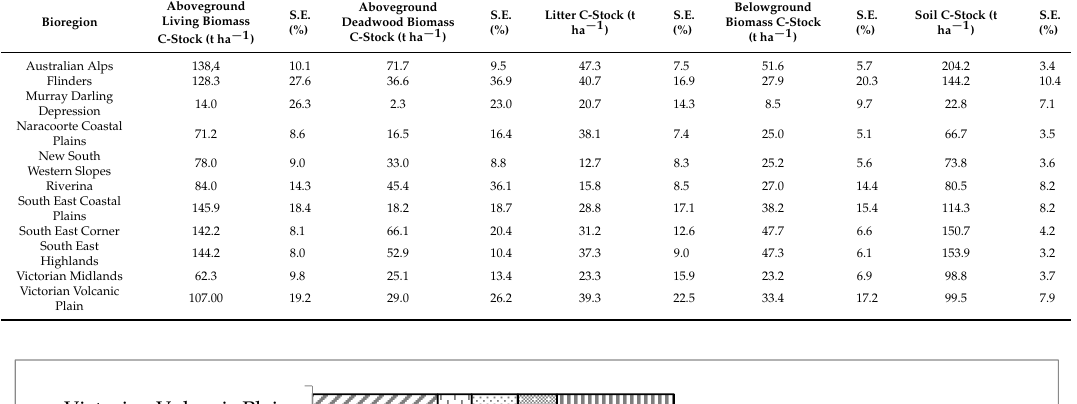
Table 3. Public land forest area within bioregions and estimated carbon stock per hectare (with standard errors) for different carbon pools.